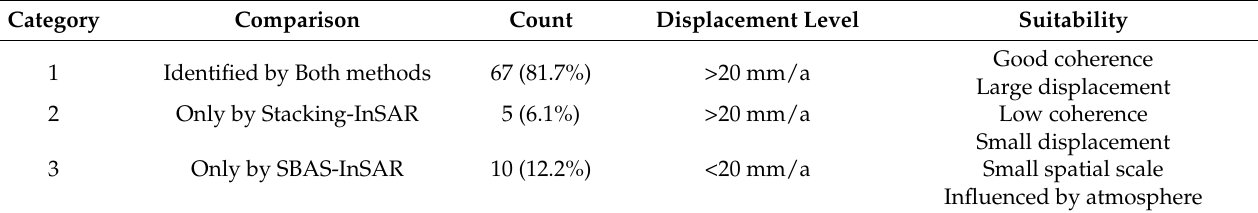
Table 2. Statistics and suitability analysis of Stacking-InSAR and SBAS-InSAR results.